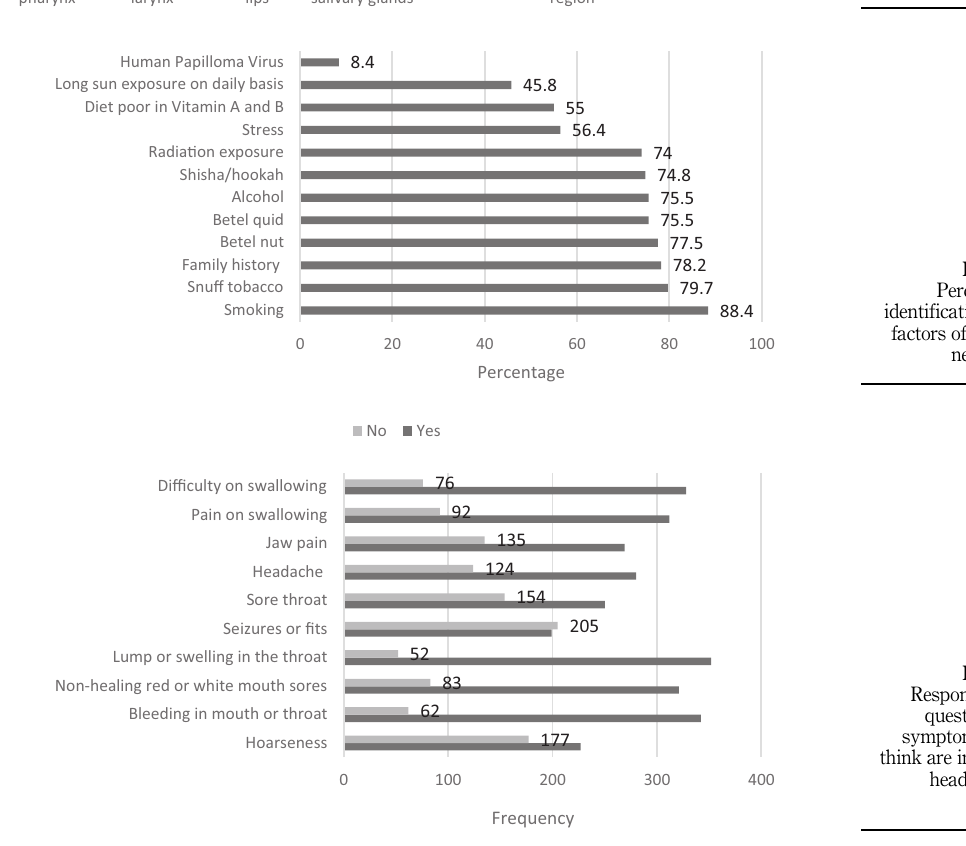
Figure 1. Responses to the question “ which cancers do you think are included in head and neck cancers? ”